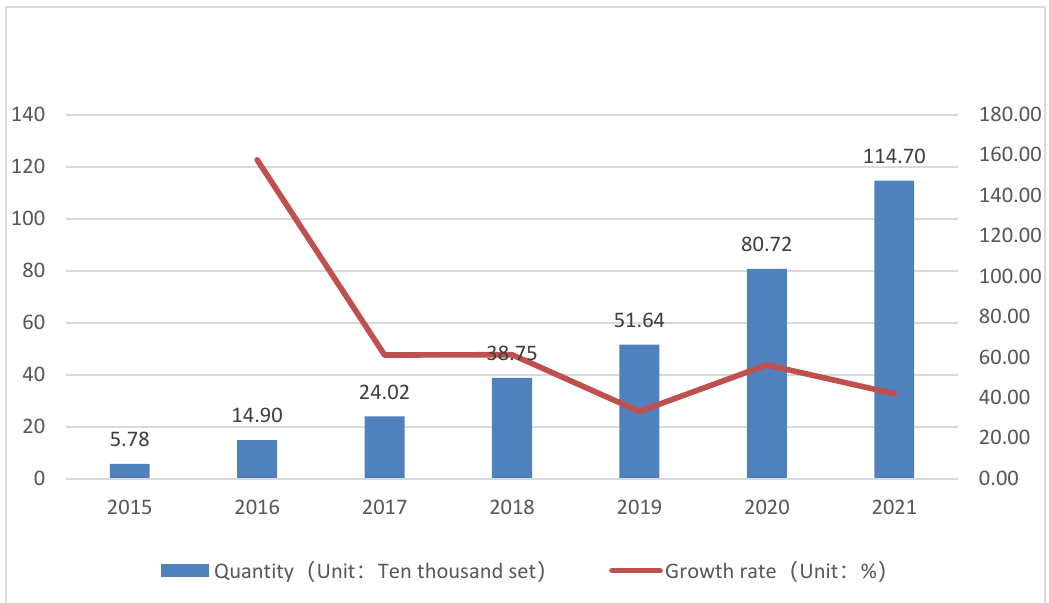
Figure 2. Number of public EV charging piles in China from 2015 to 2021. Data source: China Electric Vehicle Charging Infrastructure Promotion Alliance